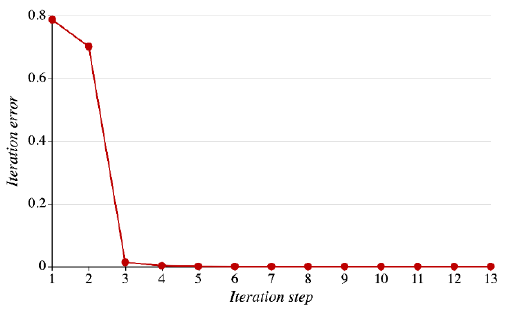
Figure 18. Iteration error with LREA.